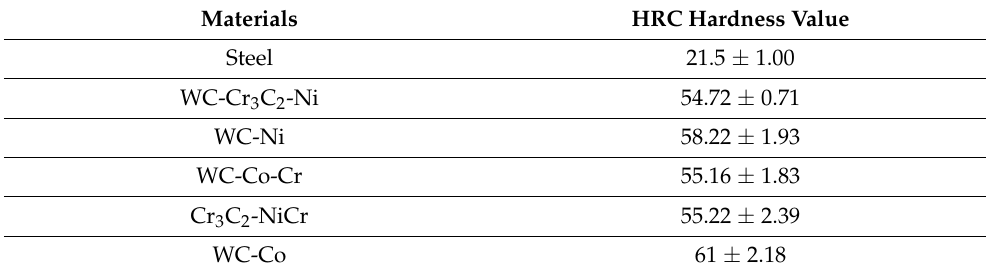
Table 3. HRC values of carbon steel substrate and HP-CS coatings.